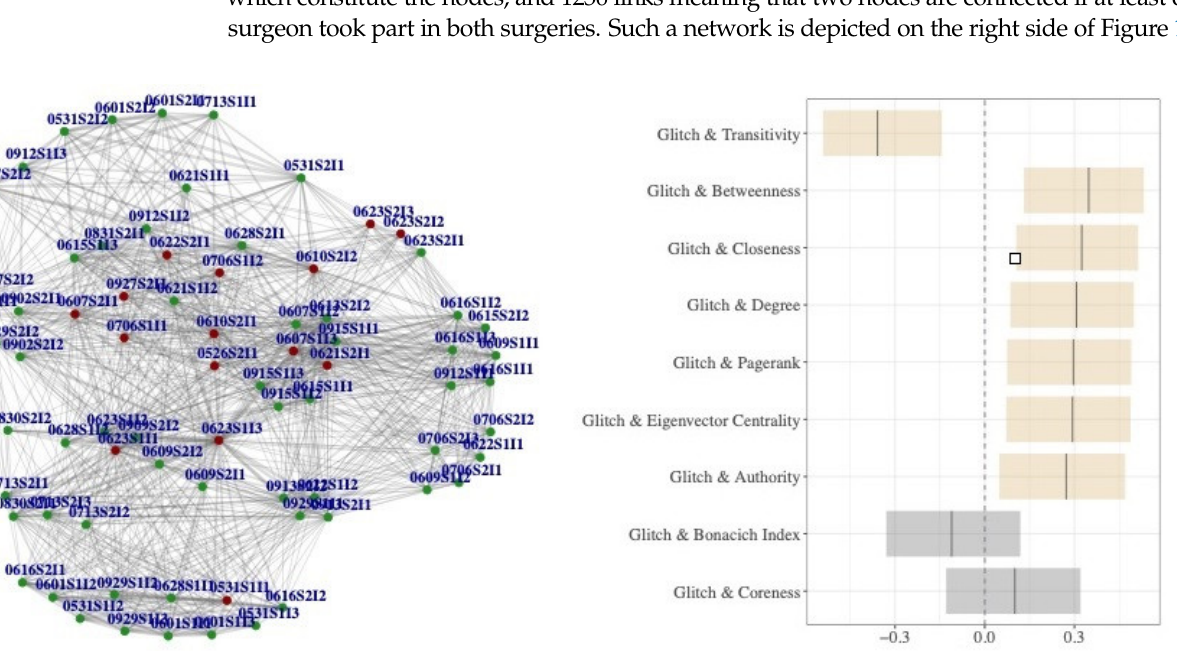
Figure 1. The network projection of the surgery rooms interactions (left panel) and correlations between glitches and centrality measures. In the left panel, red nodes indicate the occurrence of a glitch; in the right panel, for the p -values, we obtained 0.00234 for glitch–transitivity, 0.00318 for glitch–betweenness, 0.00592 for glitch–closeness, 0.00926 for glitch–degree, 0.0119 for glitch–pagerank, 0.0127 for glitch–eigenvector centrality, and 0.0209 for glitch–authority, while we obtained 0.347 for glitch–Bonacich index and 0.393 for glitch–coreness (note that these last two correlations are depicted with the boxplot filled in grey).